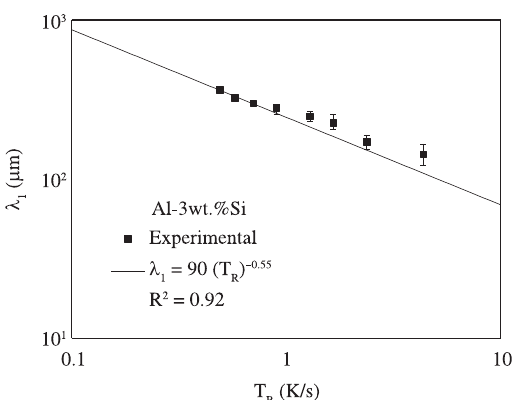
Figure 13. Primary dendrite arm spacing as a function of cooling rate for the Al- 3wt.%Si alloy.